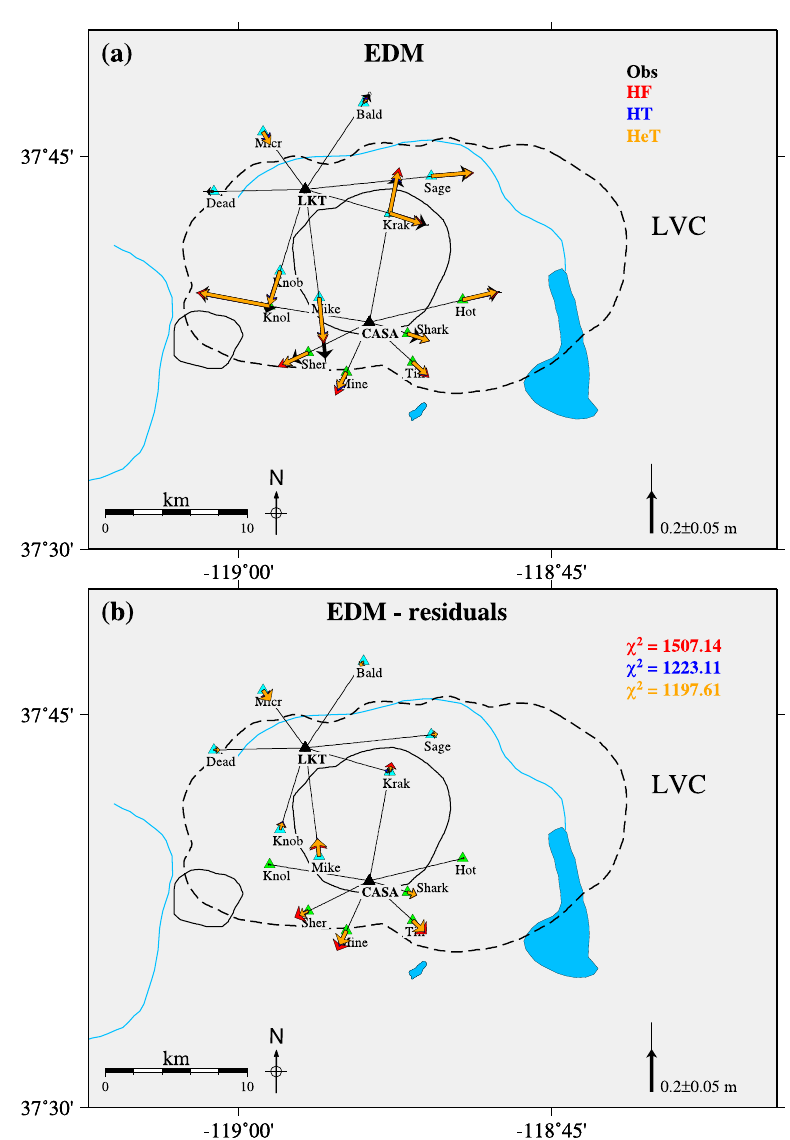
Figure 6. ( a ) Comparison between observed (black arrows with thin solid line as error) and modeled (colored arrows corresponding to different model configurations) EDM baseline length changes. ( b ) Corresponding residuals between modeled and observed baseline length changes. Obs: observa- tions; HF: homogeneous flat crust; HT: homogeneous crust with topography; HeT: heterogeneous crust with topography. χ 2 values for each model are shown on top right.